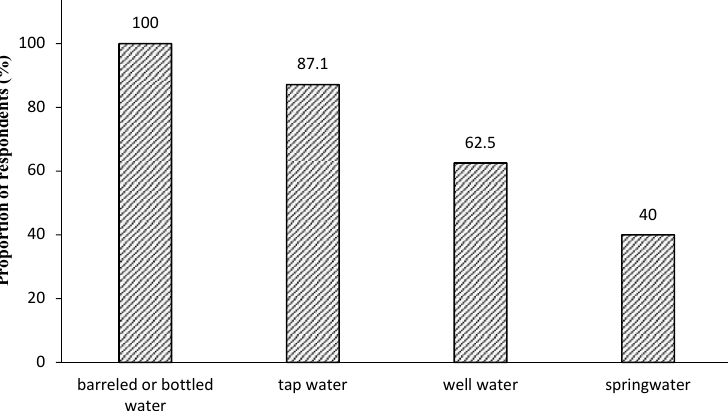
Figure 2. Degree of public satisfaction of different drinking water sources quality. Note: the same respondent ticked more than one alternative.